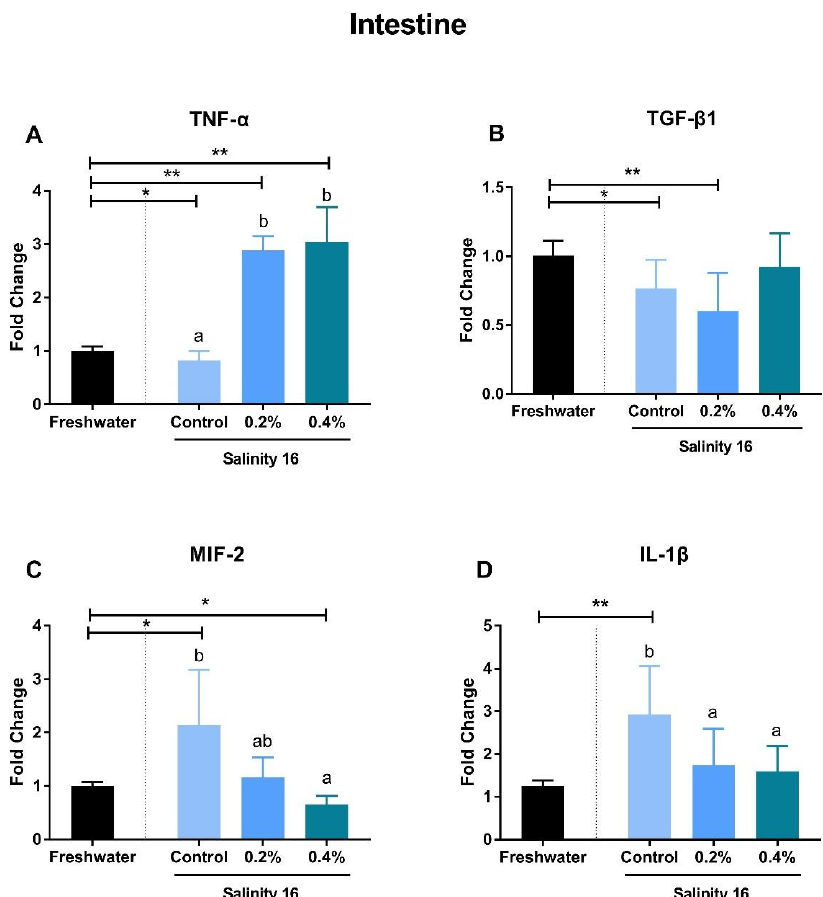
Figure 3. The gene expression of TNF- α ( A ), TGF- β 1 ( B ), MIF-2 ( C ), and IL-1 β ( D ) in the intestine of O. niloticus fed diets with β -glucan in freshwater and brackish water. A single asterisk (*) indicates a significant di ff erence ( p < 0.05), and two asterisks (**) indicate an extremely significant di ff erence ( p < 0.01). Di ff erent letters with a,b indicated significant di ff erences among three treatments in 16 salinity water ( p < 0.05).